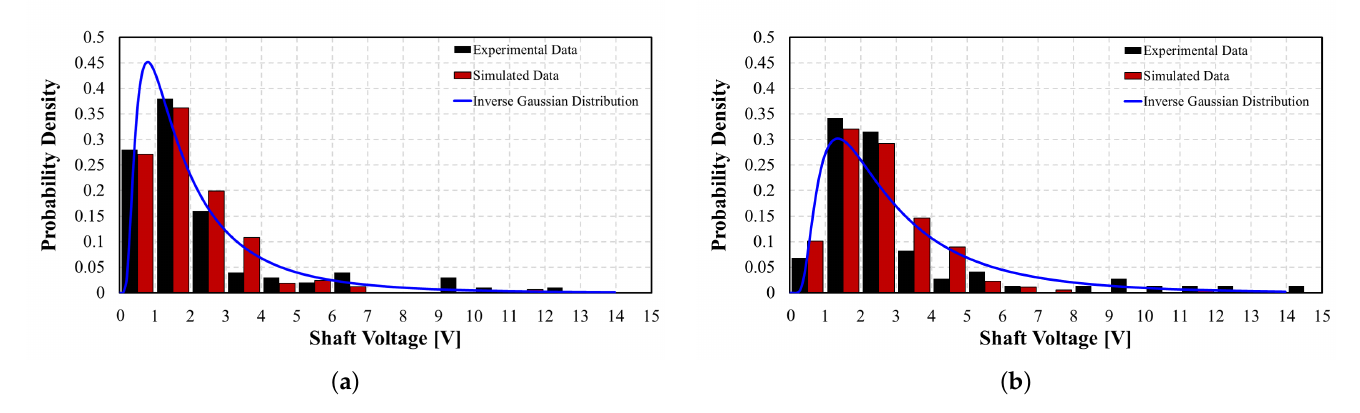
Figure 19. Histogram and inverse Gaussian distribution for shaft voltage at 3000 rpm: ( a ) 360 V; ( b ) 600